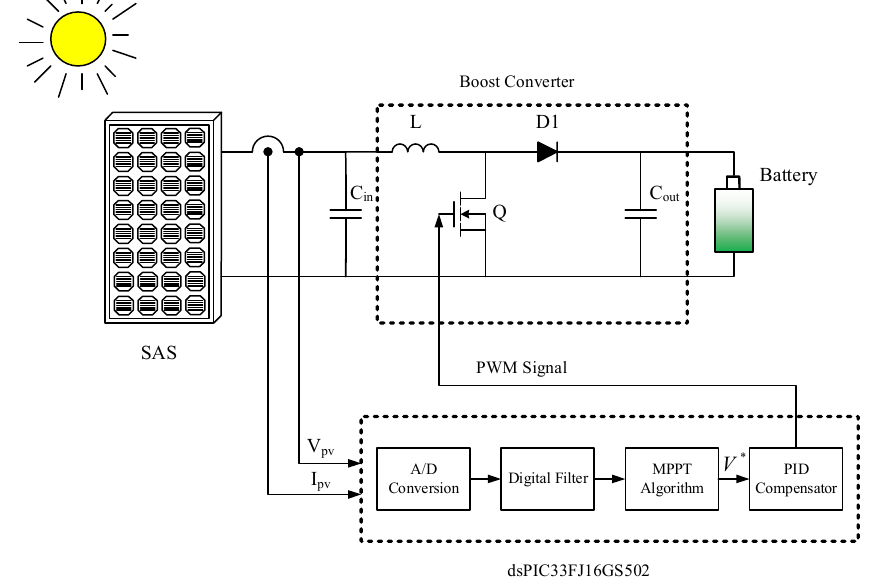
Figure 7. The block diagram of the proposed system. A/D: Analog-to-Digital; PID: Proportional-Integral-Derivative.